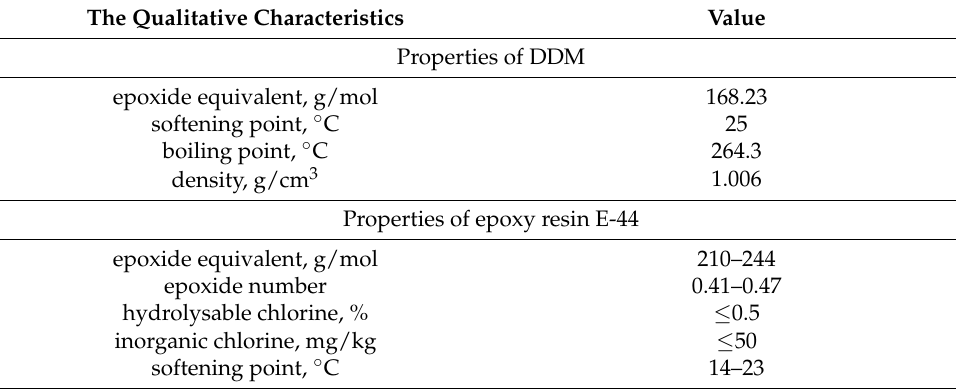
Table 1. Typical properties and specifications of EP and